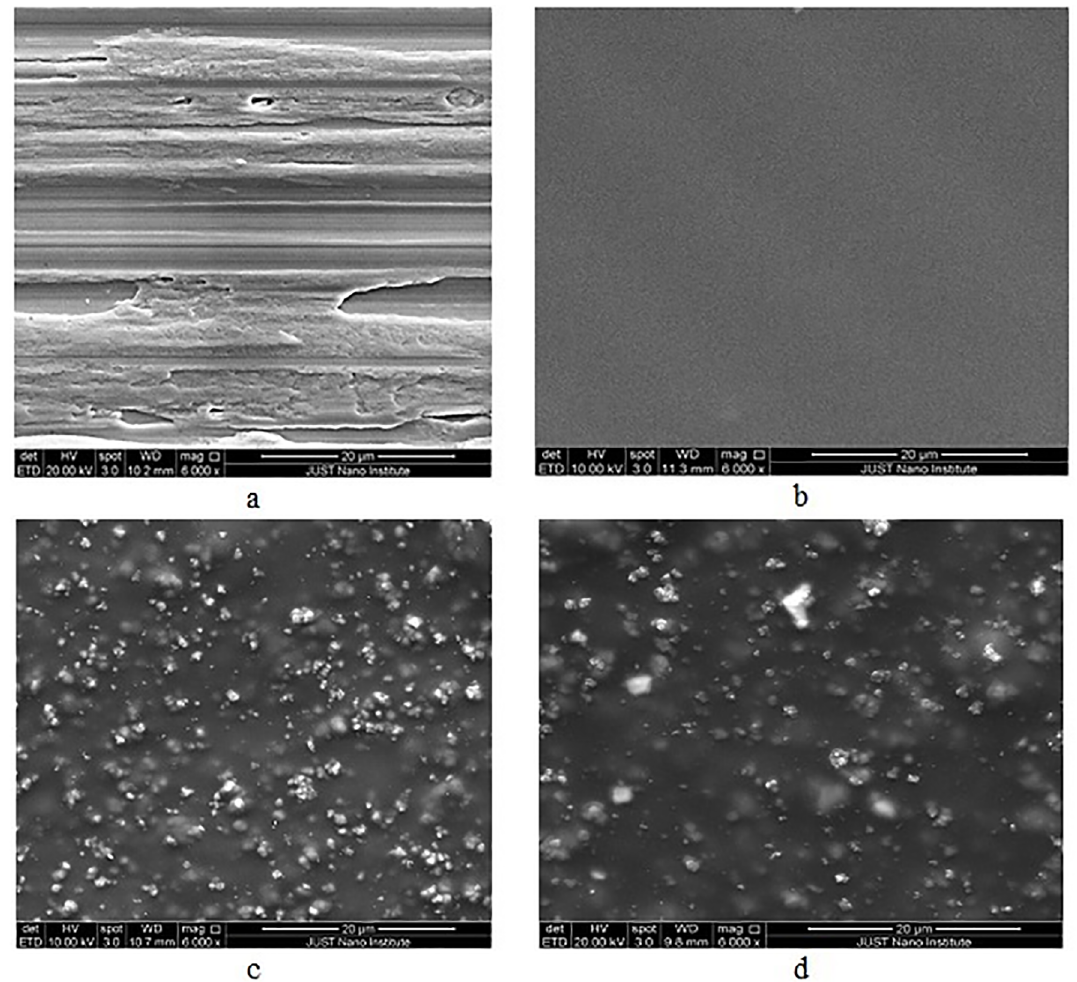
Figure 1 . (a) Surface morphology of the AISI 304 steel before conducting the corrosion test, (b) SEM image of pure gelatin-coated sample before the corrosion test, (c) SEM image of hybrid TiO corrosion test, (d) SEM image of hybrid TiO